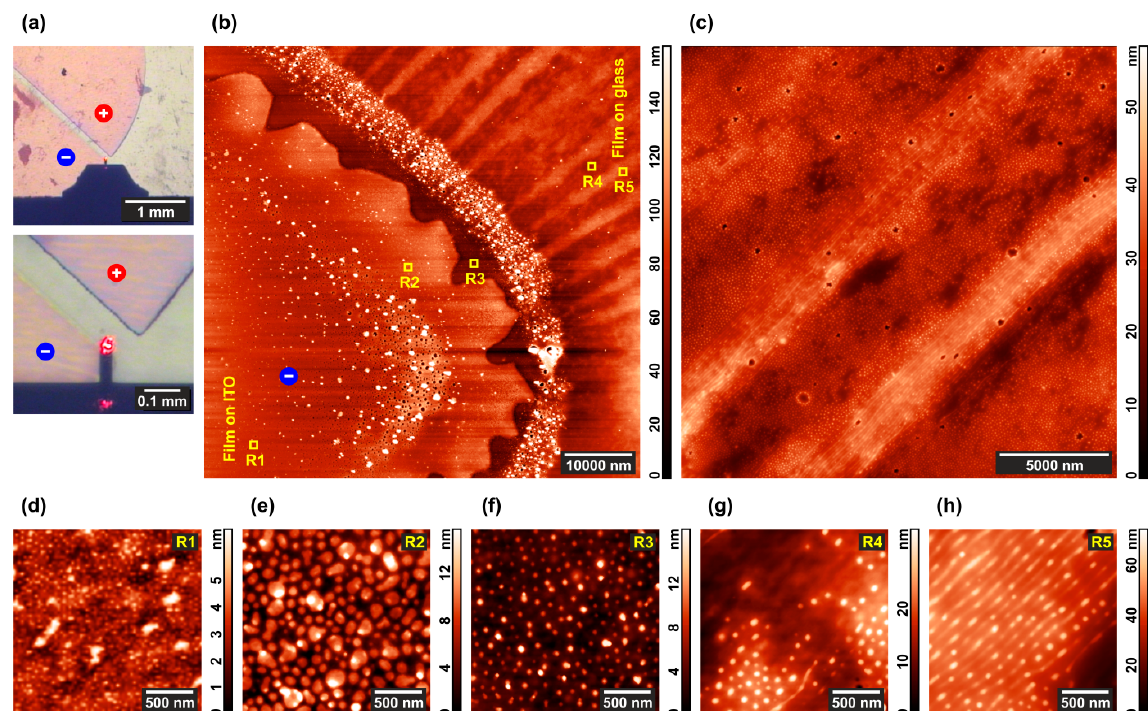
Figure 7. Details of the morphology in the microphase-separated PS–P4VP/AuNR film annealed under chloroform vapor and DC field. ( a ) Optical images of the electrodes; ( b ) AFM image of the near-cathode area of the film; ( c ) more detailed AFM image of the composite film between the electrodes; ( d – h ) AFM images of the typical domain structures in the R1-R5 regions marked in the image ( b ).